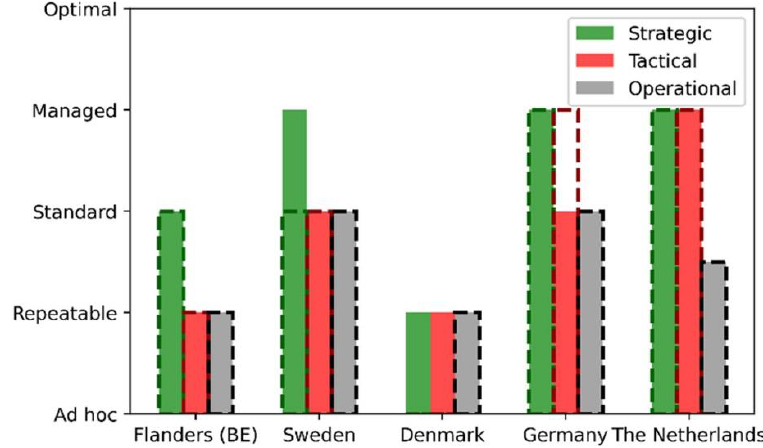
Figure 3. Results of the asset owners perceived maturity for the strategic, tactical and operational context at the start of the project (dashed lines) and towards the end (solid bars).